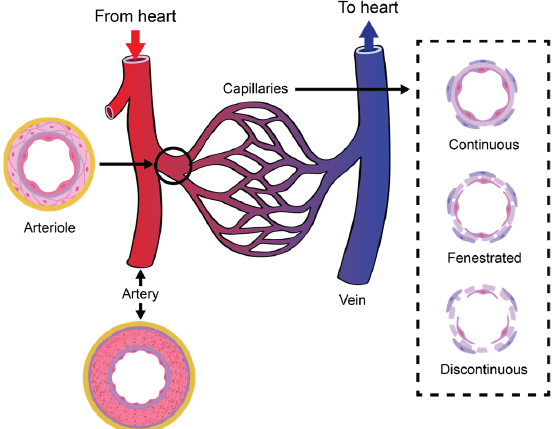
Figure 1. Illustration of a typical vascular tree based on [37]. Arteries and arterioles in blue; capillary beds, veins, and venules in red. All vessels are made of an inner layer of endothelium and an outer layer of the basement membrane. Arterioles and venules are also covered by a second layer of smooth-muscle cells, as well as elastin and collagen fibres. A basement membrane is composed of pericytes and endothelial cells wrapped around capillaries, and this coverage can be continuous, fenestrated, or discontinuous.